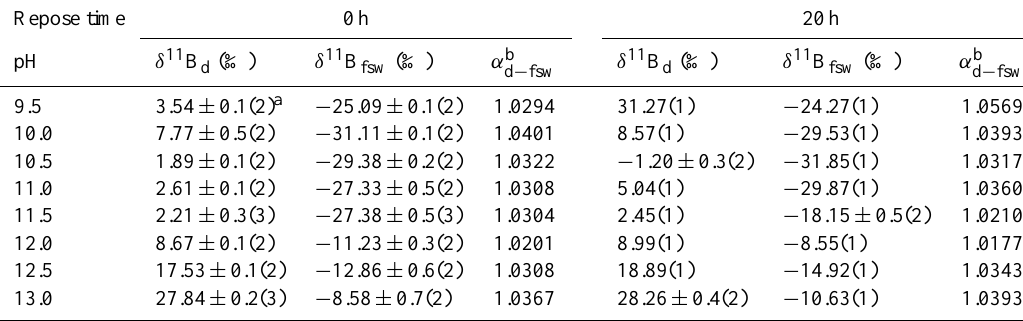
Table 3. Isotopic fractionation of boron between deposited brucite and solution.